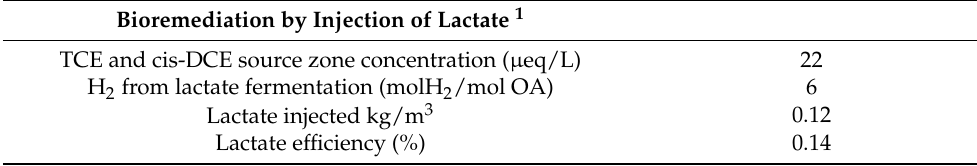
Table 1. Stimulation of the RD activity by lactate in a case study 1 .